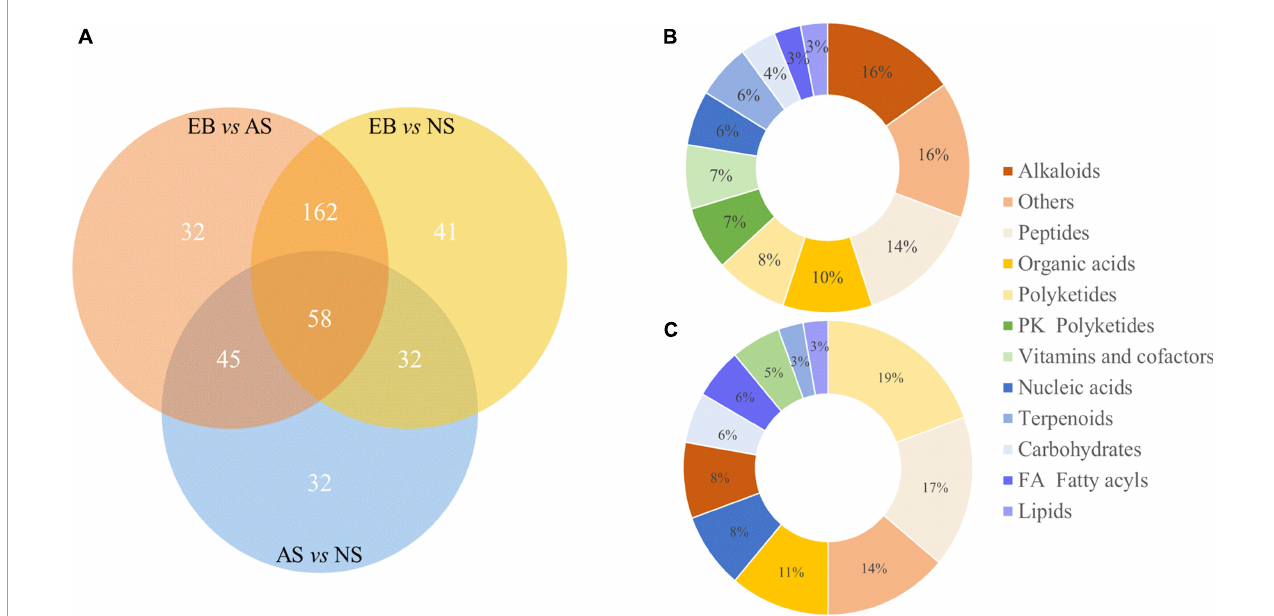
FIGURE6 Venn diagram of differential metabolites in the three comparison groups of EB vs. AS, EN vs. NS, and AS vs. NS (A) , and KEGG classification of significant different metabolites before and after fermentation (B) and under aerobic and anaerobic conditions (C) . AS, aerobic fermentation supernatants; NS, anaerobic fermentation supernatants; EB, extractives of Polygonati Rhizoma before fermentation.